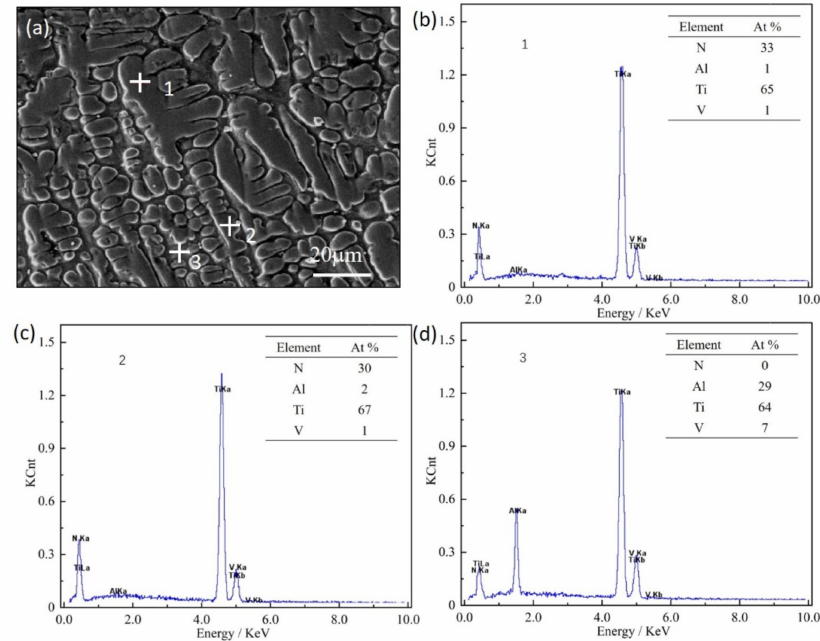
Figure 5. The energy spectrum curves of EDX point scanning. ( a ) SEM image of the cross section of the nitrided layer showing Positions 1, 2, and 3. ( b ) The energy spectrum curves of Position 1. ( c ) The energy spectrum curves of Position 2. ( d ) The energy spectrum curves of Position